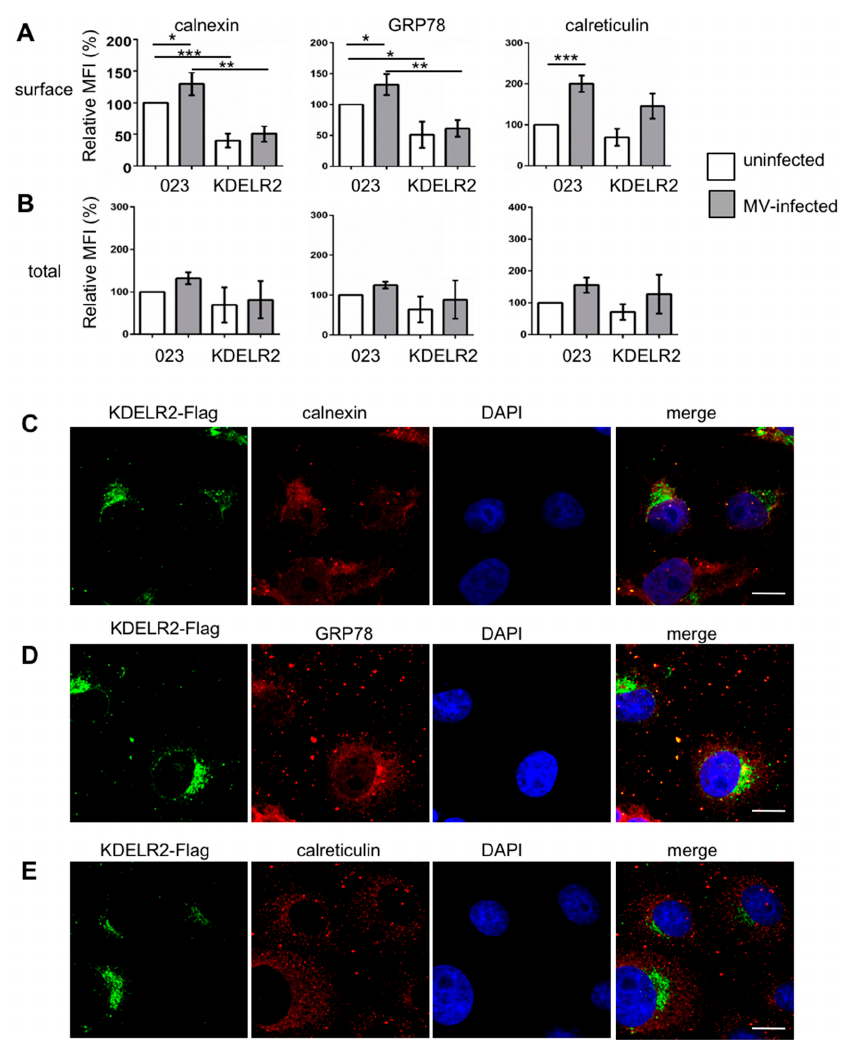
Figure 5. KDELR2 over-expression reduces the surface expression of calnexin and GRP78. Surface ( A ) and total ( B ) chaperone expression were quantified by flow cytometry. Vero-023 and KDELR2 over-expressing Vero cells (KDELR2) remained uninfected (open columns) or were infected with MV-eGFP for 48 h at a MOI of 0.1 (grey columns). Cells were stained after fixation (surface, A ), and after fixation and permeabilization (total, B ) with antibodies to calnexin, GRP78, and calreticulin as indicated, and the fluorescence intensities were evaluated by flow cytometry. Exclusively, eGFP-positive cells were evaluated as infected cells and eGFP-negative cells as uninfected cells. Data representative of three independent experiments were normalized to values of uninfected Vero-023 cells, and are presented as relative mean fluorescent intensities (MFI). Significances were determined using the Student’s t-test. The subcellular localization of the chaperones calnexin ( C ), GRP78 ( D ), and calreticulin ( E ) in comparison to KDELR2-Flag and nuclei (DAPI) was analyzed using a confocal microscope (enlargement 1000 × ; size bar = 20 µ